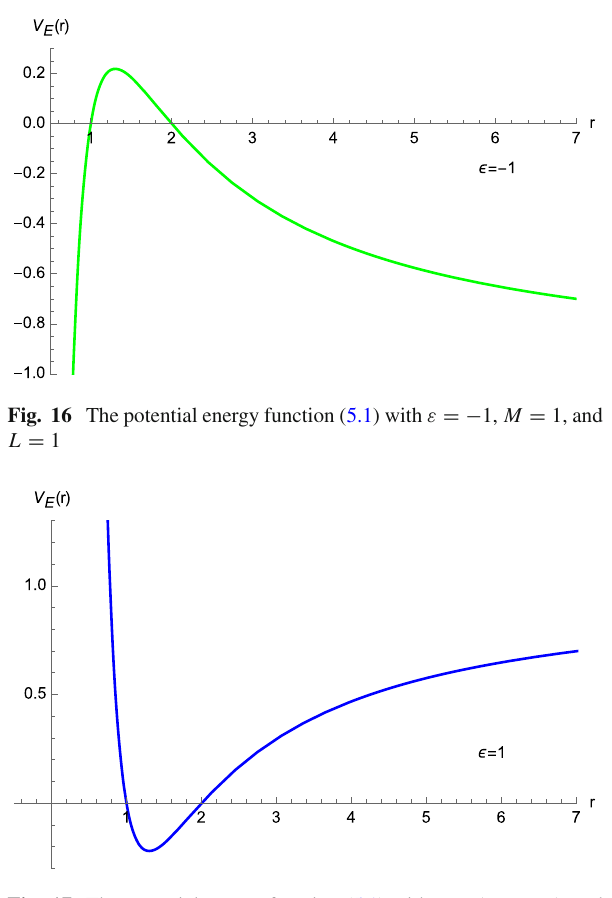
Fig. 17 The potential energy function (5.1) with ε = 1, M = 1, and L =